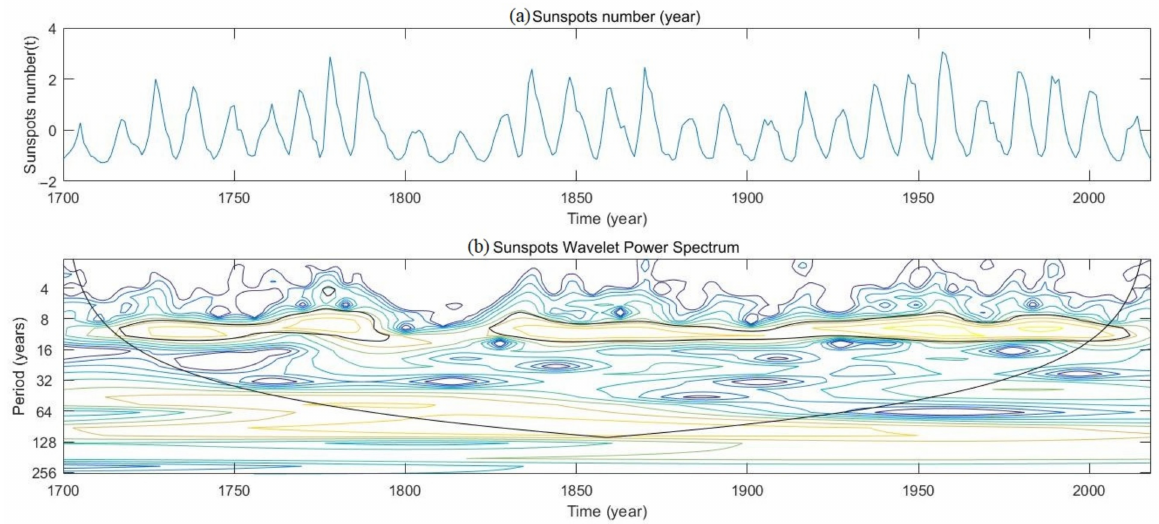
Figure 6. Results of ( a ) the change of sunspots number, ( b ) wavelet power spectrum of sunspots number series; value in the black solid line represents the 95% confidence level.